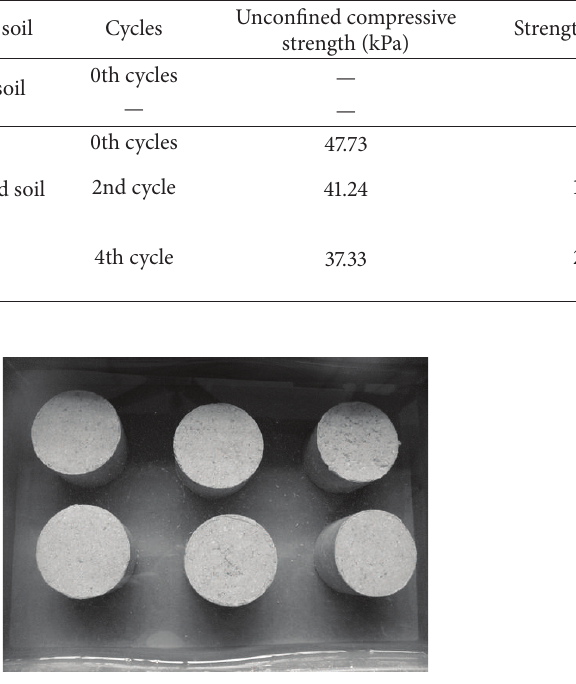
Figure 7: Improved samples immersed in water for 48h at 0 wetting-drying cycles.